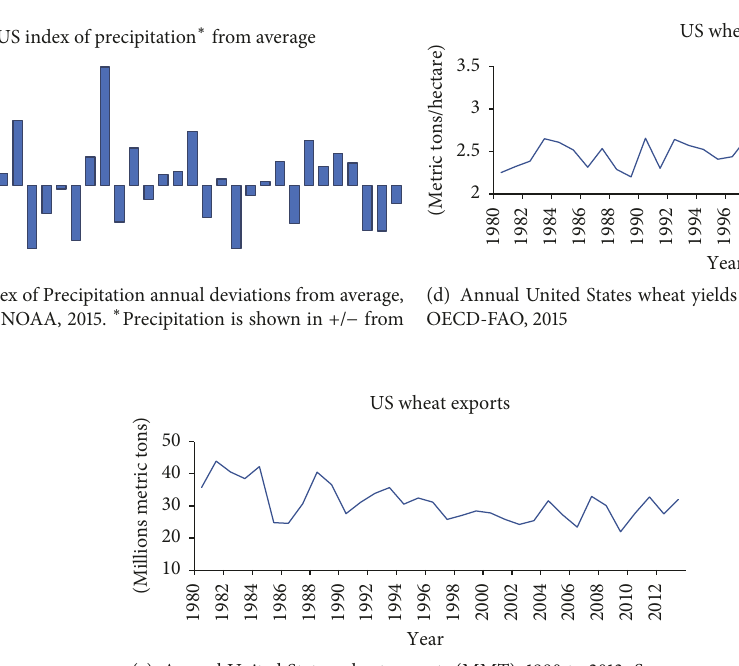
Figure 7: United